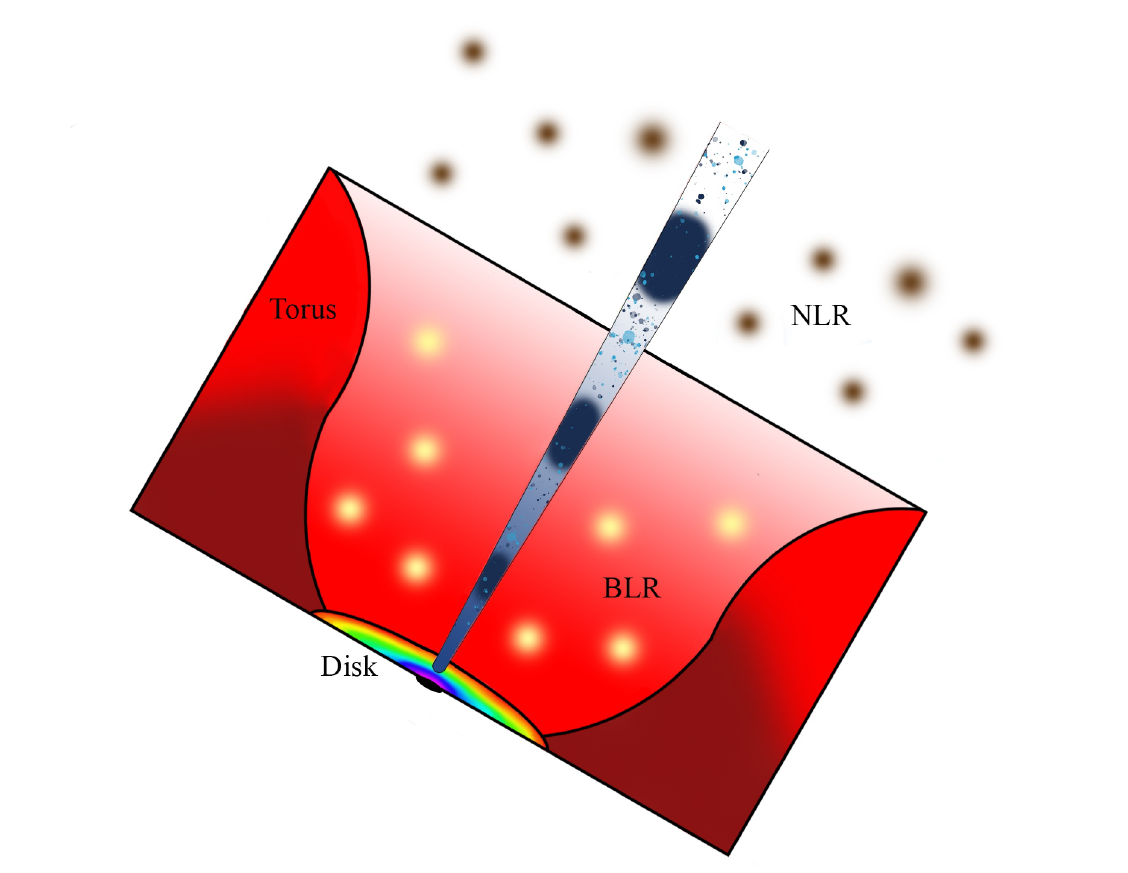
Figure 1. Schematic representation (not in scale) of the central regions of a radio-loud